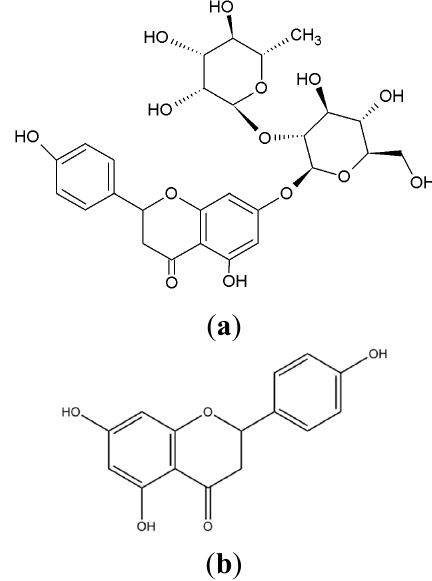
Figure 1. Chemical structures of naringin ( a ) and naringenin ( b